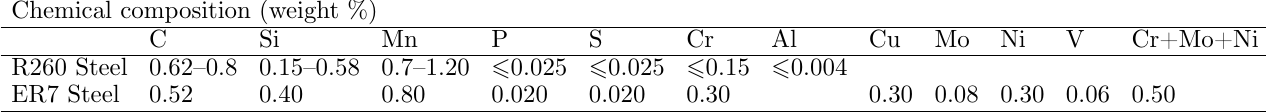
Fig. 5. Triboring test bench, a disc in rotation on a circular rail (the ring) [12]. Table 2. Chemical composition of R260 Steel [18] and ER7 steel [20], (weight %). Chemical composition (weight